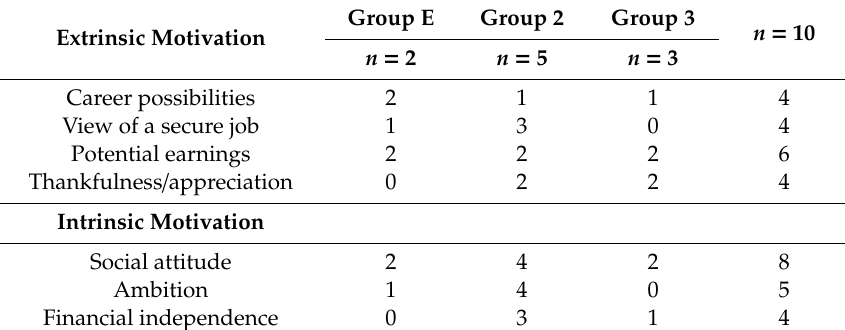
Figure 1. Results on how to awaken interest on this profession. Table 1. Results on the motivation to work as a professional nurse.